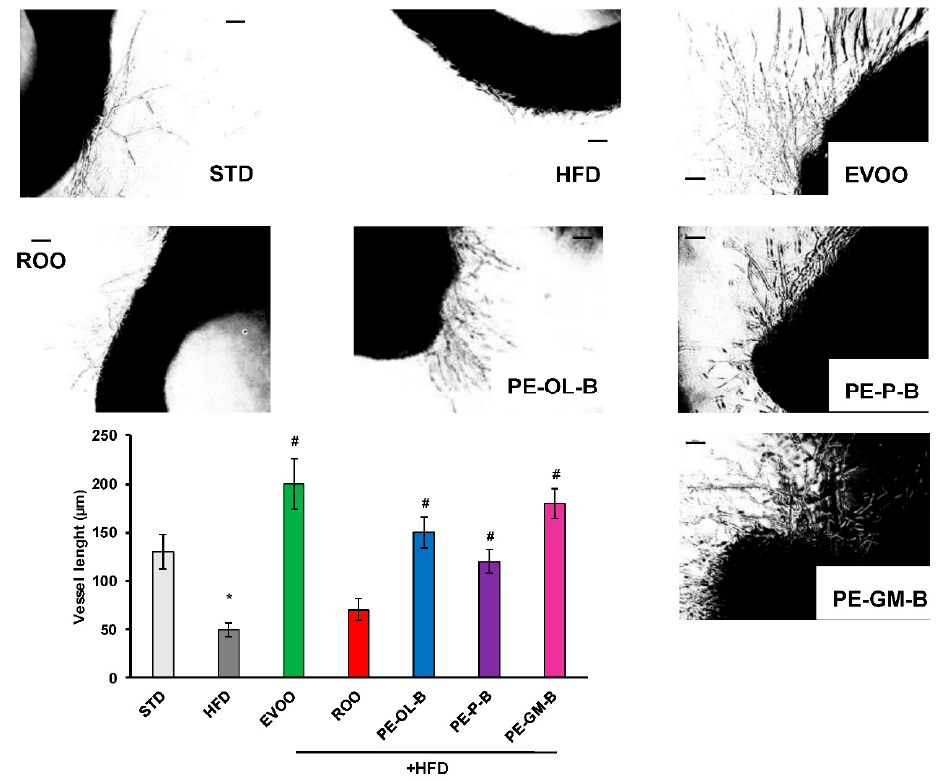
Figure 9. Diet supplementation of HFD fed rats with EVOO, ROO, PE-OL-B, PE-P-B, and PE-GM-B affects vessel sprouting formation from aortic rings. Aorta rings were treated with VEGF (25 ng/mL). Vessel sprouting formation was determined as the number of grid units covering the surface occupied by pseudo-capillaries in each well and expressed as vessel length. n = 4 rats. * p ≤ 0.05 vs. STD; # p ≤ 0.05 vs. HFD. Each experimental point is run at least in triplicate. Scale bar 100 μ m.